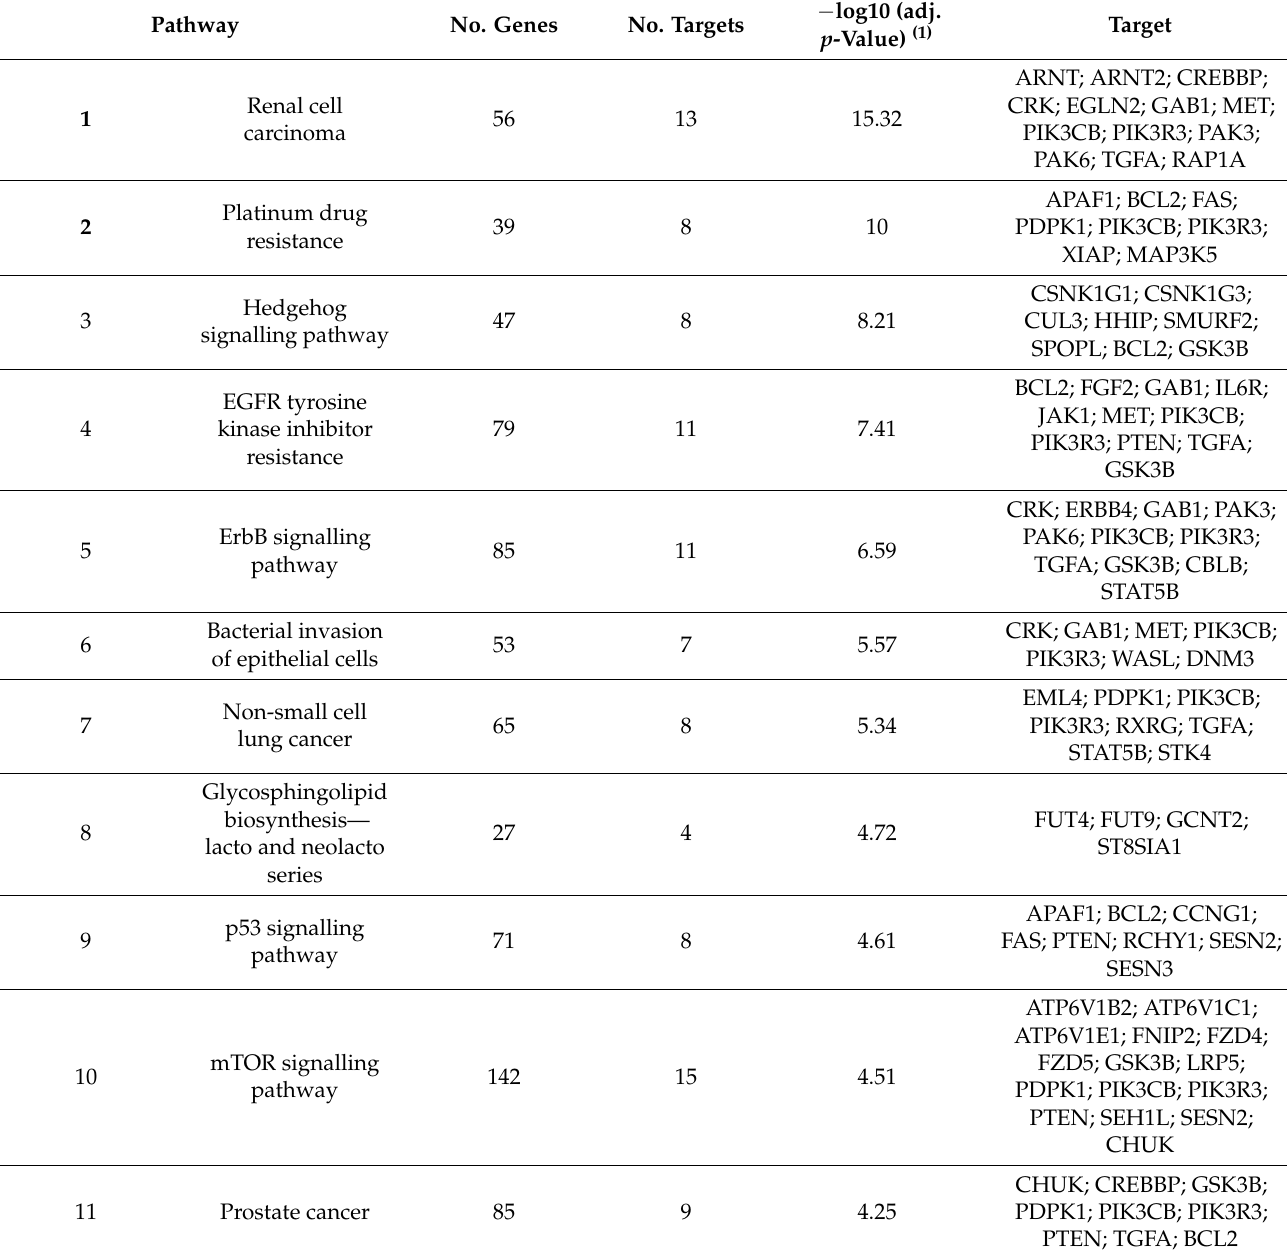
Table 6. Over-representation analysis of KEGG pathways for miR-23a-3p target genes. Differentially expressed pathways (Adjusted p -value ≤